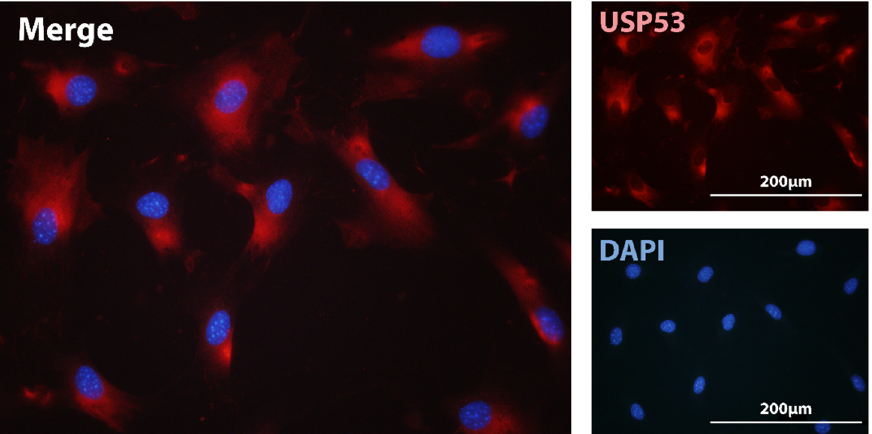
Figure 1. Cytoplasmic localization of USP53 in osteoblast cells. Localization of USP53 in MC3T3-E1 osteoblast cells was examined using immunofluorescence with antibodies against endogenous USP53 (red) and nuclear staining with DAPI (blue). Cytoplasmic localization of USP53 was detected in the merged field. Magnification bars, 200 µm.